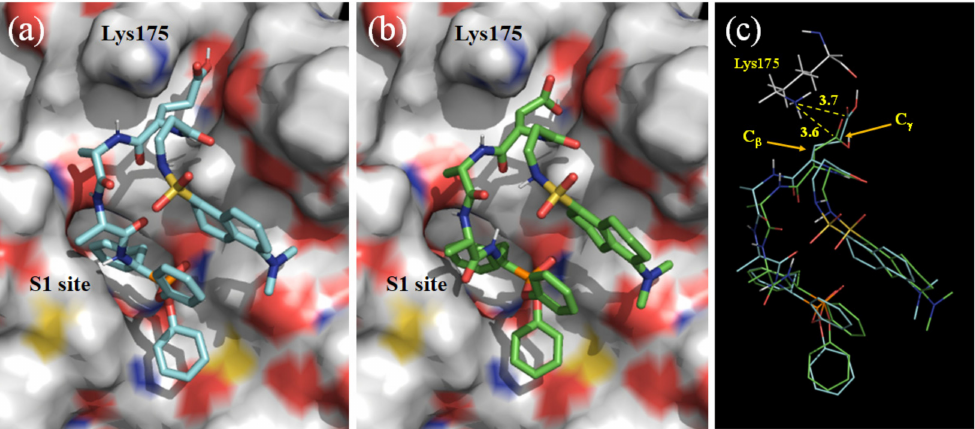
Figure 2. Estimated conformations of models DanE ( a ) and DanD ( b ) onto γ -Csin (PDB ID: 1gg6 [26,27]) with the lowest binding energies calculated via docking simulation by using AutoDock and superposition of models DanE and DanD ( c ). The distances between the ω -carboxy carbons of models DanD and DanE and the nitrogen of ε -amino group of Lys175 were estimated to be 3.6 and 3.7 Å, respectively.